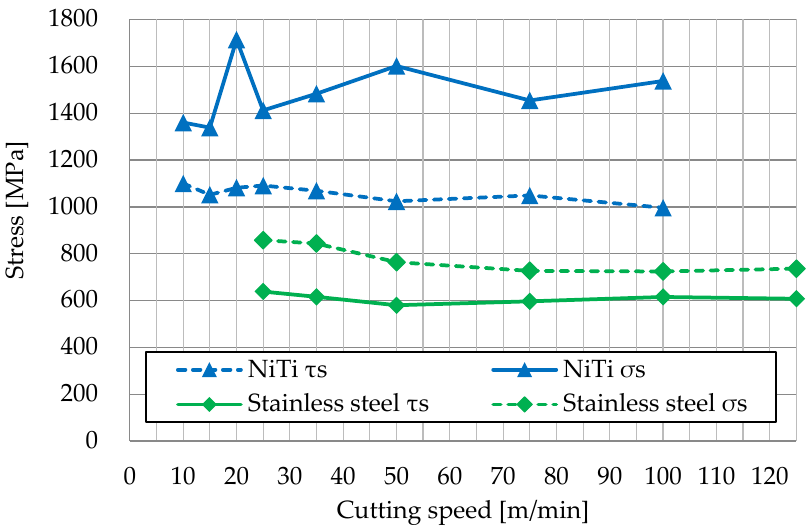
Figure 12. Shear stress and normal stress calculated from the shear surface theory.